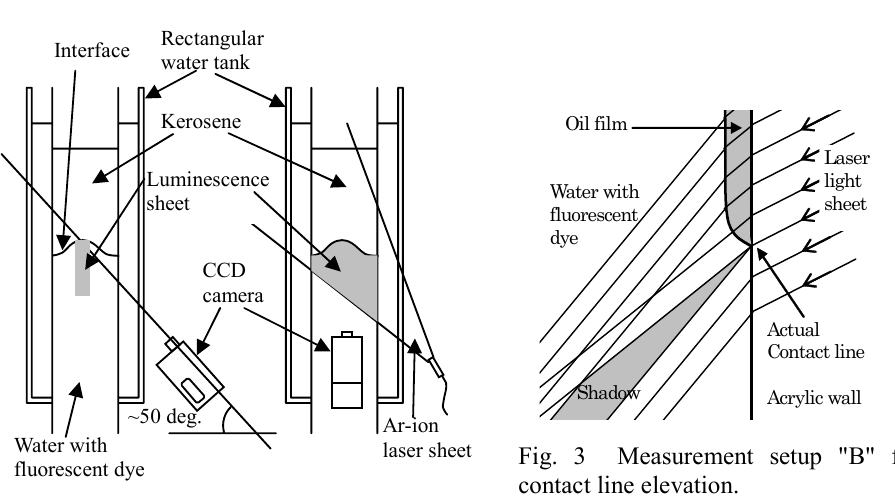
Fig. 3 Measurement setup "B" for contact line elevation.